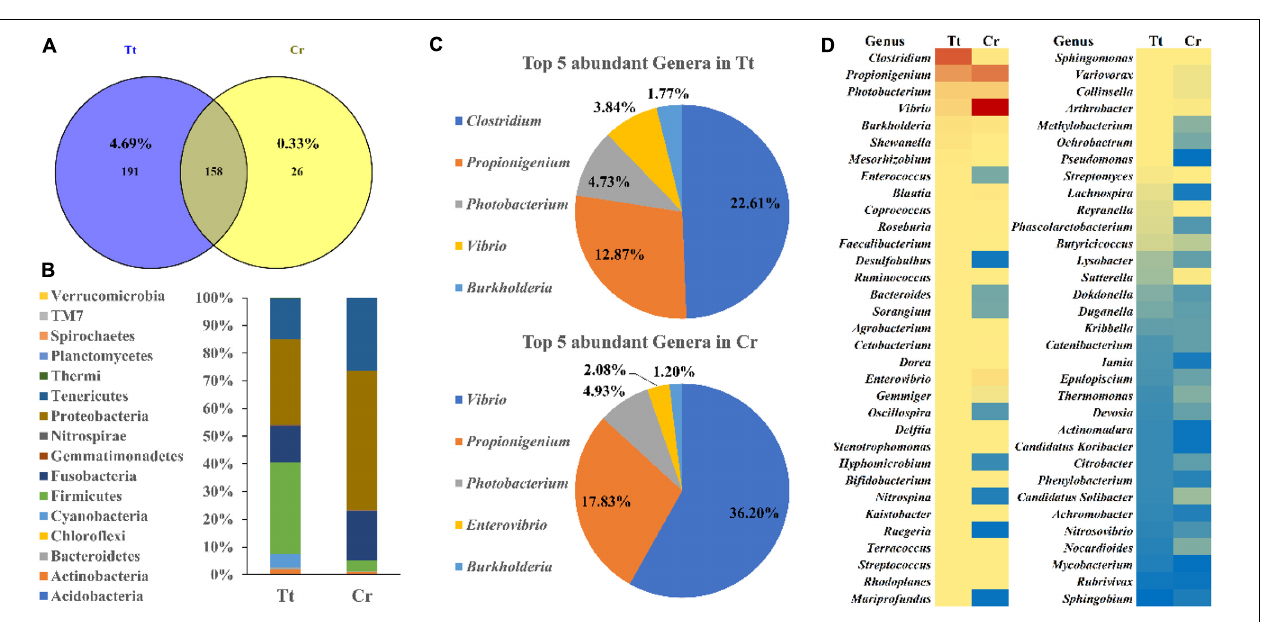
FIGURE 4 | Gut microbiota diversity of two Asian horseshoe crabs C. rotundicauda (CR) and T. tridentatus (Tt). (A) Comparing OTUs identified in two horseshoe crabs; (B) Phylum abundance of identified OTUs in the gut of T. tridentatus and C. rotundicauda ; (C) Top 5 most abundant genera identified in the two horseshoe crabs; (D) Comparison of the abundance of common genera in both species. The abundance is shown in blue to red (low to